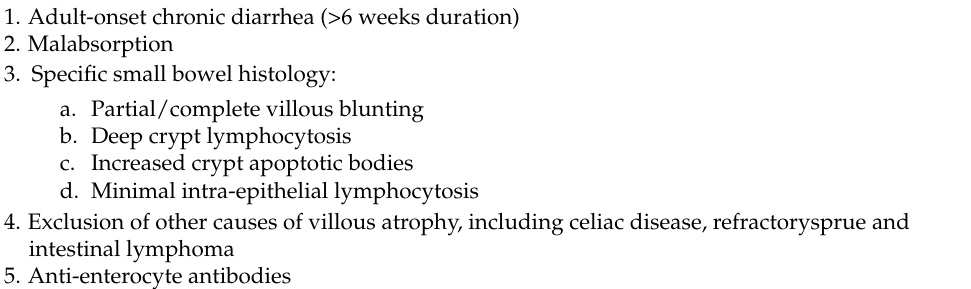
Table 1. Proposed diagnostic criteria for adult autoimmune enteropathy (created in accordance with Akram et al.